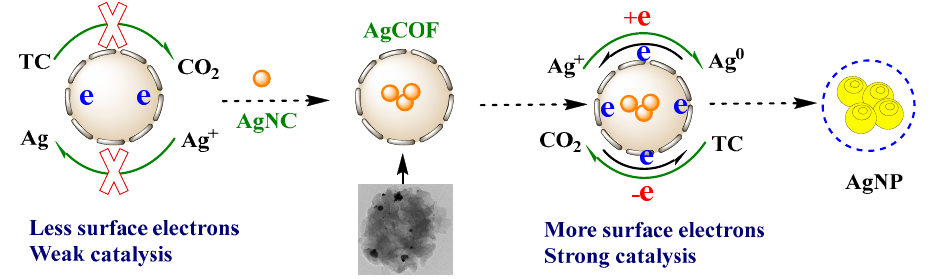
Figure 9. Catalytic mechanism of AgCOF.